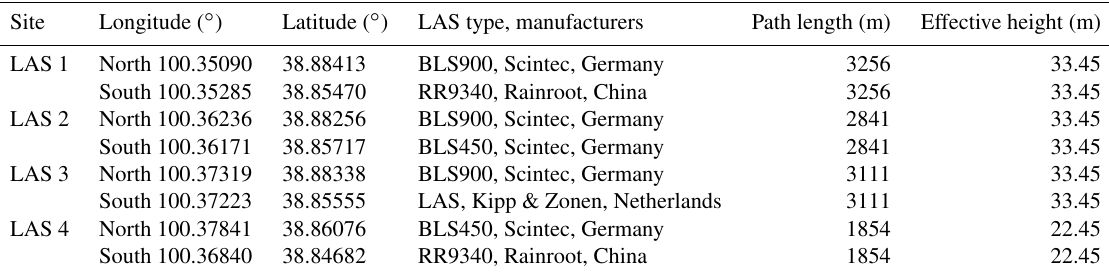
Table 2. Details of large-aperture scintillometers in the HiWATER flux matrix.